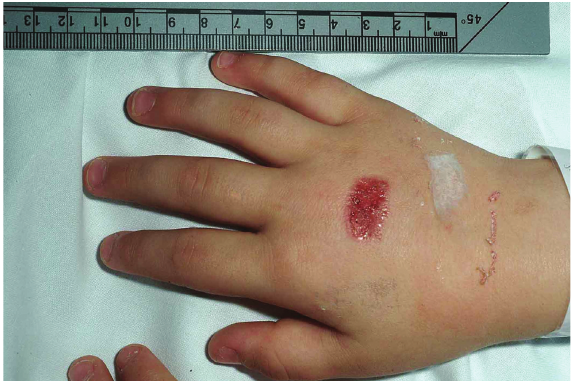
Figure 2: Salbutamol inhaler-induced burn (right